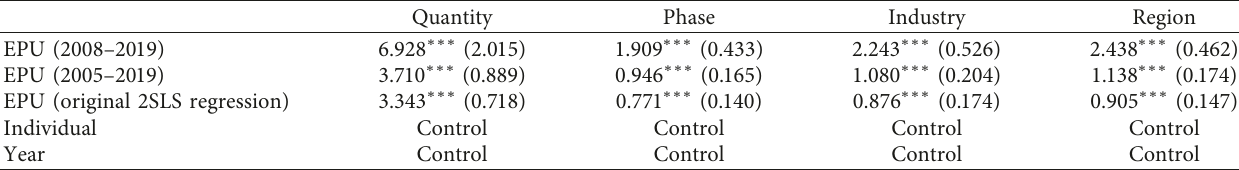
Table 6: Robustness test for split samples.